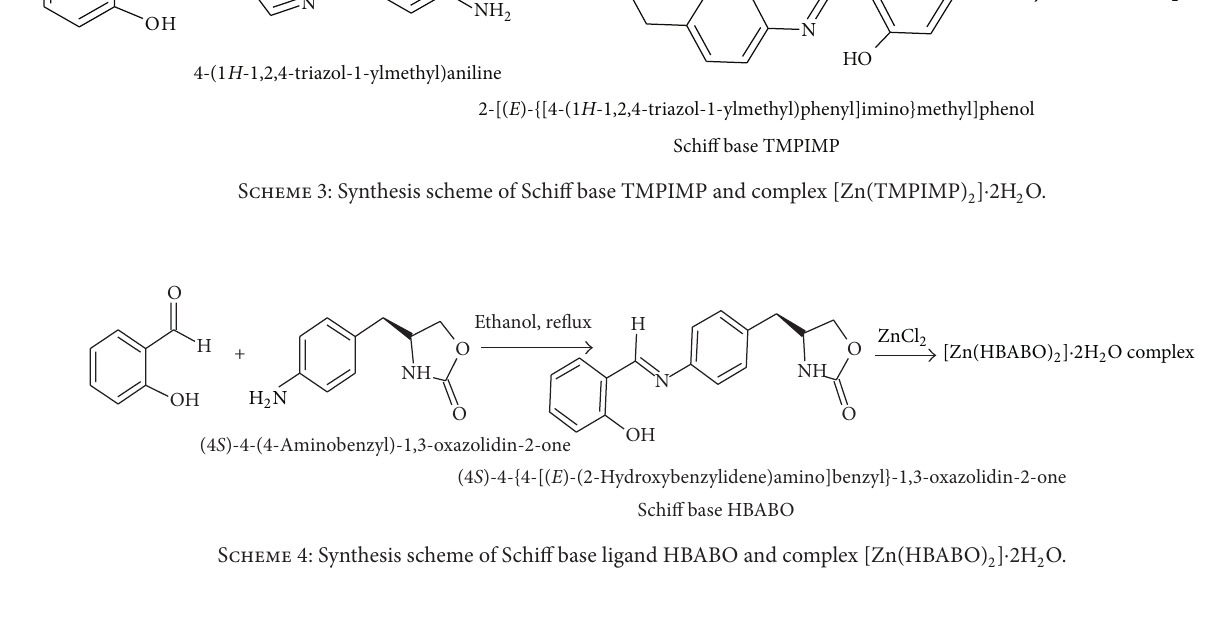
constant weight. Weight 0.40 g. Colour: light